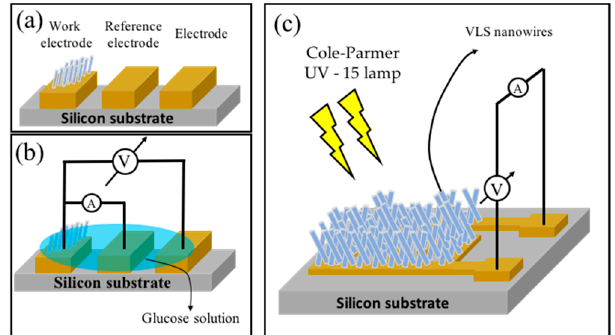
Figure 1. ( a ) Sketch of the used devices and the electrical connections and ( b ) diagram of the 4 probe setup which was performed to perform the biosensor electrical measurements and ( c ) setting the UV light sensor.